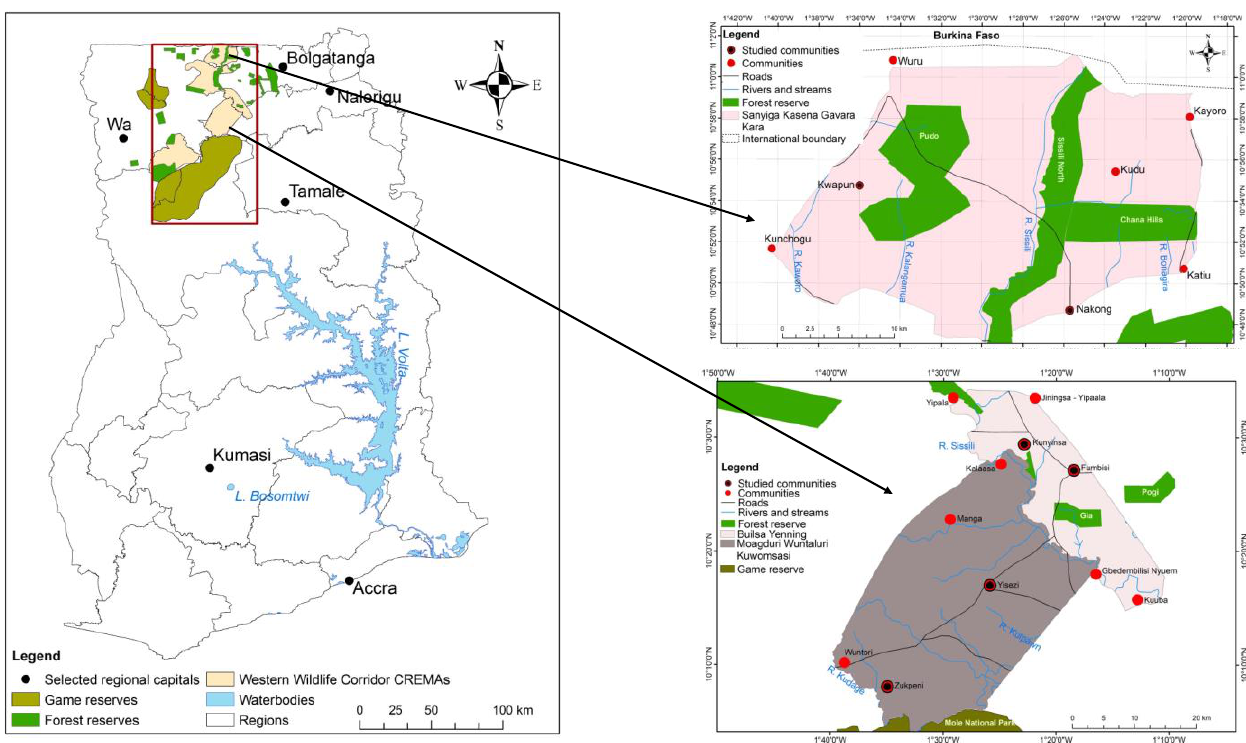
Figure 1. Location of the study area (Source: